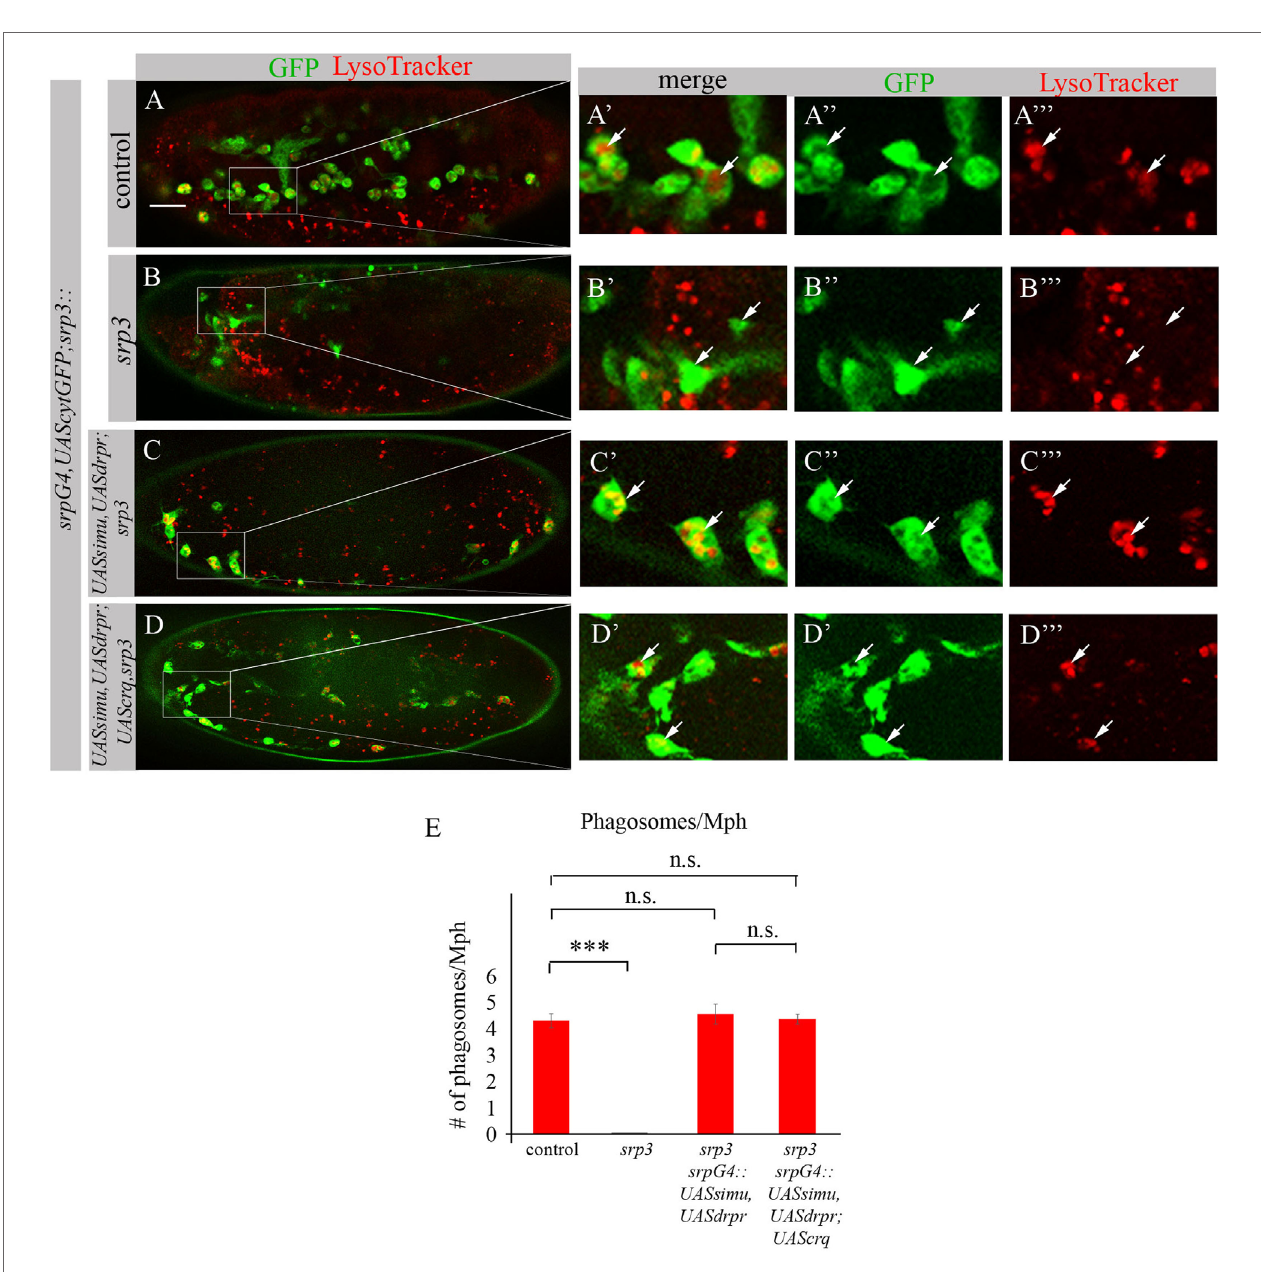
FigUre 10 | Each phagocytic receptor SIMU, Drpr or Crq rescues phagocytosis defects and distribution of srp mutant macrophages. (a–F’’’) Projections from confocal stacks of the stage 16 embryos. Macrophages are labeled with srpGal4,UAScytGFP [green, (a,a’,B,B’,c–c’’,D–D’’,e–e’’,F–F’’) ], SIMU protein with anti-SIMU [blue, (a,a’’,B,B’’) ] and apoptotic cells with anti-Dcp-1 [red, (a,a’’,B,B’’,c,c’,c’’’,D,D’,D’’’,e,e’,e’’’,F,F’,F’’’) ]. (a–a’’) Control srpGal4,UAScytGFP embryo. (B–B’’) srp 3 mutant embryo. (c–c’’’) srpGal4,UAScytGFP; srp 3 ::UASsimu;srp 3 . (D–D’’’) srpGal4,UAScytGFP; srp 3 ::UASdrpr;srp 3 . (e–e’’’) srpGal4,UAScytGFP; srp 3 ::UAScrq,srp 3 . (F–F’’’) srpGal4,UAScytGFP; srp 3 ::UASsimu,UASdrpr;UAScrq,srp 3 . Bar, 20 µm. (g) Columns represent mean diameter of 10 macrophages in each embryo ± SEM of following genotypes: control embryos ( n = 5), srp 3 mutant embryos ( n = 7), srpGal4,UAScytGFP; srp 3 ::UASsimu;srp 3 ( n = 6), srpGal4,UAScytGFP; srp 3 ::UASdrpr;srp 3 ( n = 5), srpGal4,UAScytGFP; srp 3 ::UAScrq,srp 3 ( n = 8) , srpGal4,UAScytGFP; srp 3 ::UASsimu,UASdrpr;srp 3 ( n = 8), srpGal4,UAScytGFP; srp 3 ::UASsimu,UASdrpr;UAScrq,srp 3 ( n = 6). Asterisks indicate statistical significance versus control, as determined by one-way ANOVA followed by Bonferroni post hoc test, *** p < 0.0001, * p < 0.05, n.s. > 0.05. (h) Columns represent mean phagocytic index ± SEM of following genotypes: control embryos ( n = 6), srp 3 mutant embryos ( n = 7), srpGal4,UAScytGFP; srp 3 ::UASsimu;srp 3 ( n = 6), srpGal4,UAScytGFP; srp 3 ::UASdrpr;srp 3 ( n = 6), srpGal4,UAScytGFP; srp 3 ::UAScrq,srp 3 ( n = 8) , srpGal4,UAScytGFP; srp 3 ::UASsimu,UASdrpr;srp 3 ( n = 8), srpGal4,UAScytGFP; srp 3 ::UASsimu,UASdrpr;UAScrq,srp 3 ( n = 6). Asterisks indicate statistical significance versus control, as determined by one-way ANOVA followed by Bonferroni post hoc test, *** p <